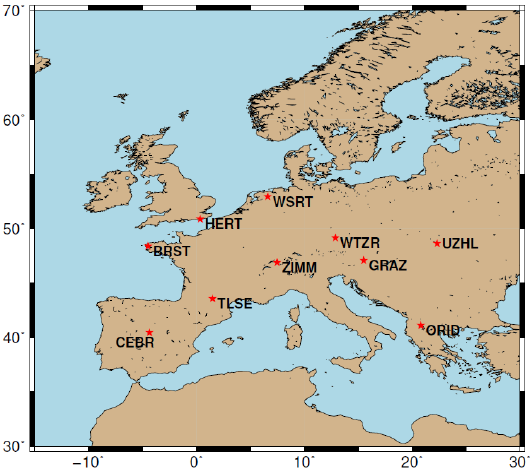
Figure 10. Distribution of 10 receiver stations within the densification area used for the dSTEC